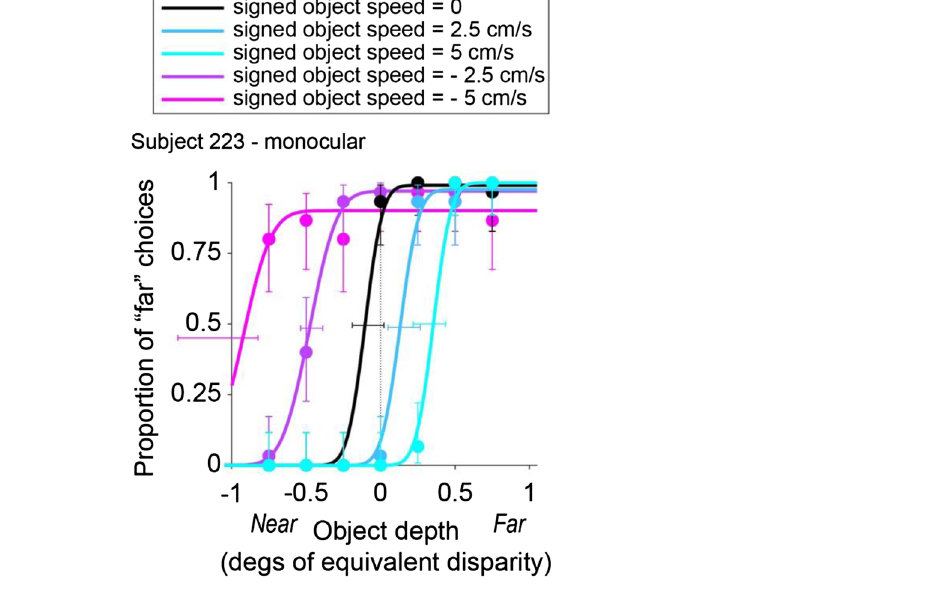
Figure 4. Data from an example subject in the monocular condition. Depth psychometric functions are shown for subject 223, color coded according to whether self-motion and object motion have the same direction (negative SOS, shades of purple), opposite directions (positive SOS, shades of blue), or there is no object motion (black). Different object speeds are indicated by color saturation. Vertical error bars indicate 95% confidence intervals for the proportion of “far” choices. Horizontal error bars indicate 95% confidence intervals for the PSE values obtained from the